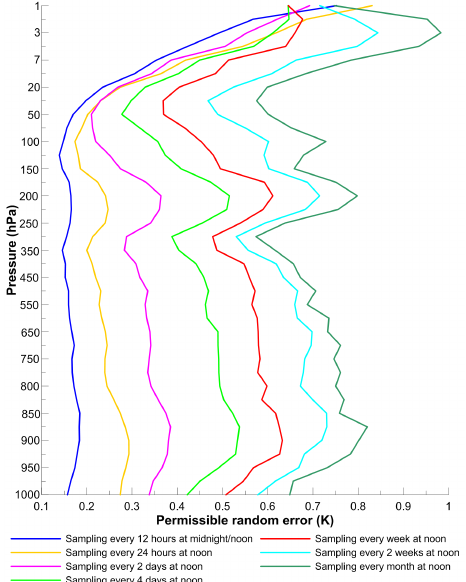
Figure 4. The permissible uncertainty in temperature measurements for a range of sampling frequencies required to avoid more than 10% increase in the uncertainty in the monthly means compared to the monthly mean uncertainty that would result from sampling with 0.01K uncertainty. Results from all 87 sites selected for this analysis and for all months were averaged to produce this